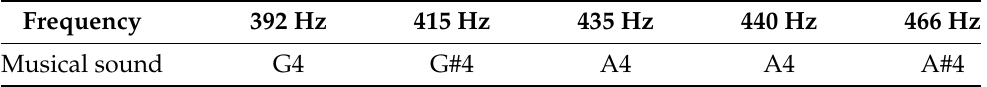
Table 4. Musical sounds used today juxtaposed with historical frequencies of